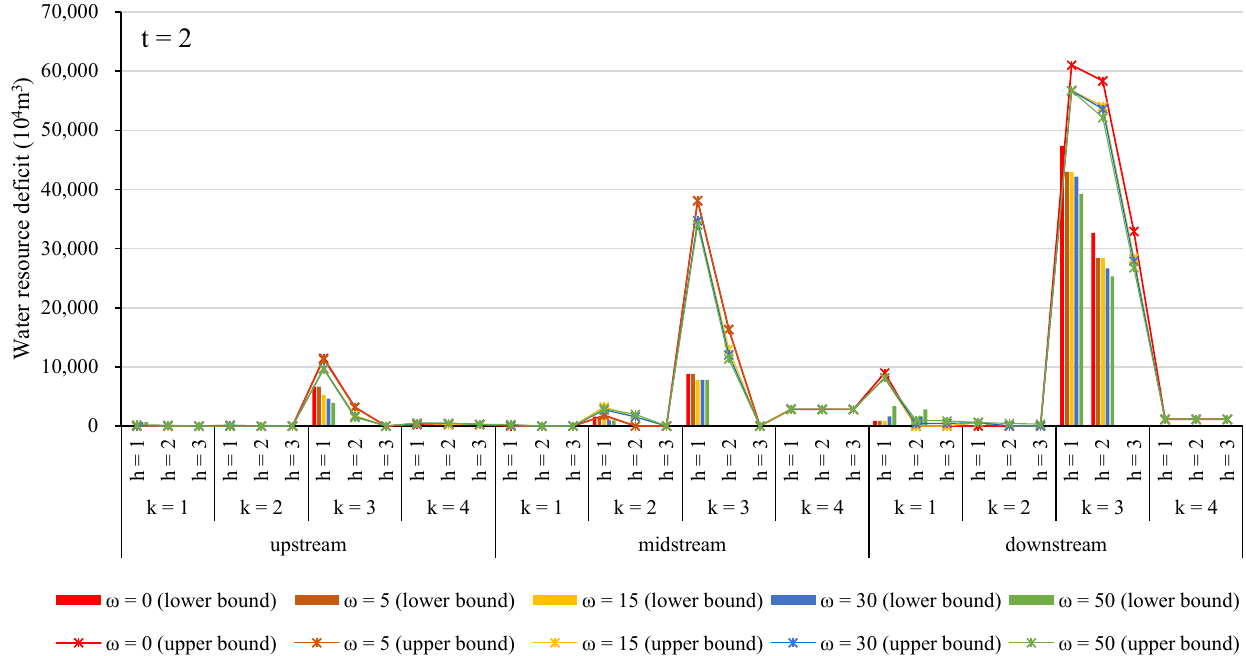
Figure 9. Water resource deficit by region in the Fenhe River Basin in period 2.